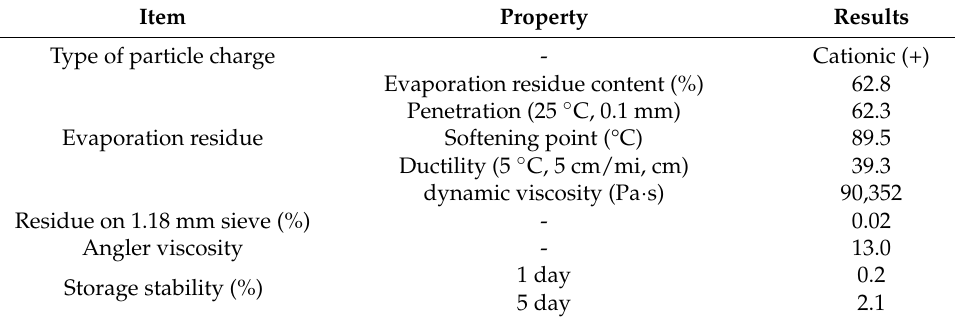
Table 1. Parameters of emulsified asphalt.